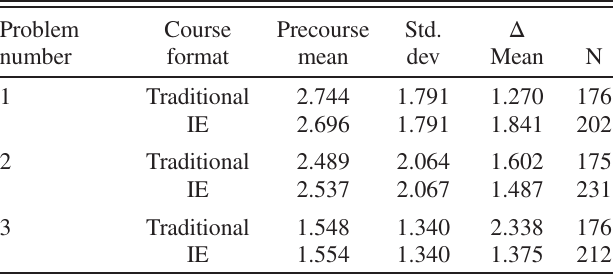
TABLE I. Total precourse mean problem-solving scores (and standard deviations) and increase in postcourse total problem- indicates the average of the difference between each student ’ s pre and postcourse